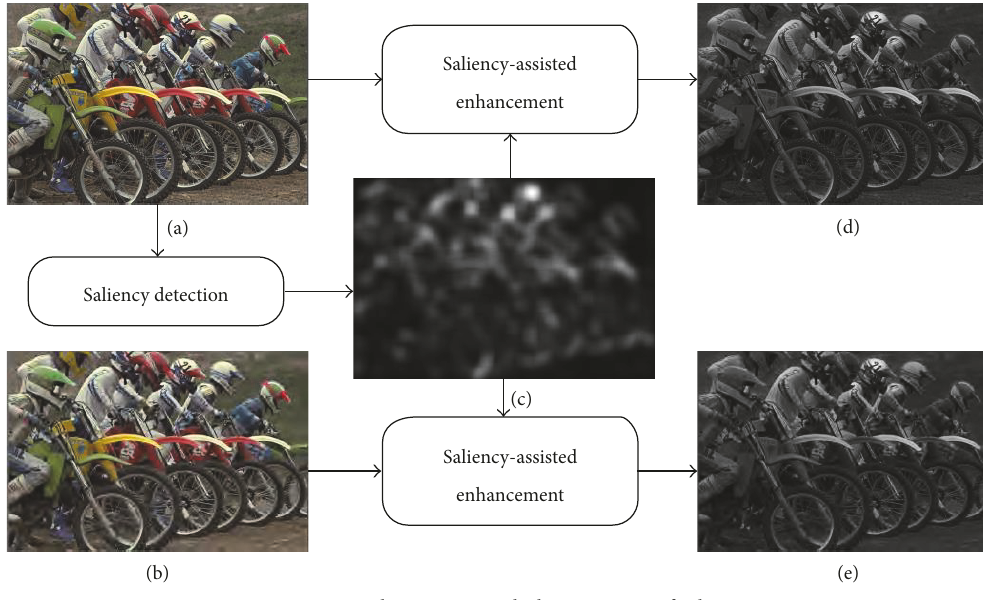
Figure 3: Image enhancement with the assistance of saliency